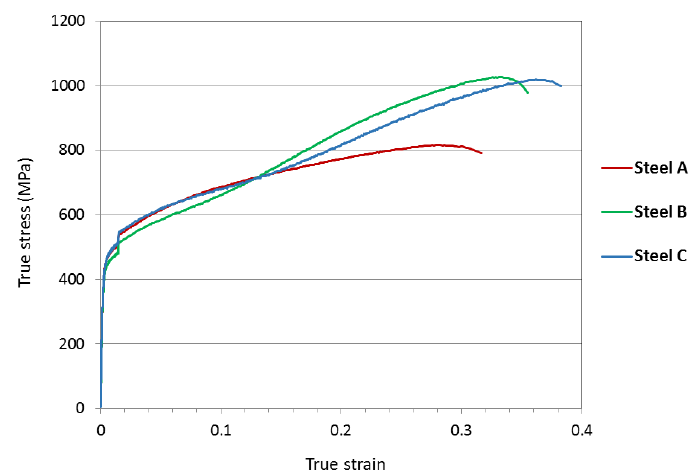
Figure 2. Tensile true stress–true strain graphs for the studied materials. Table 1. Tensile properties of the studied materials.